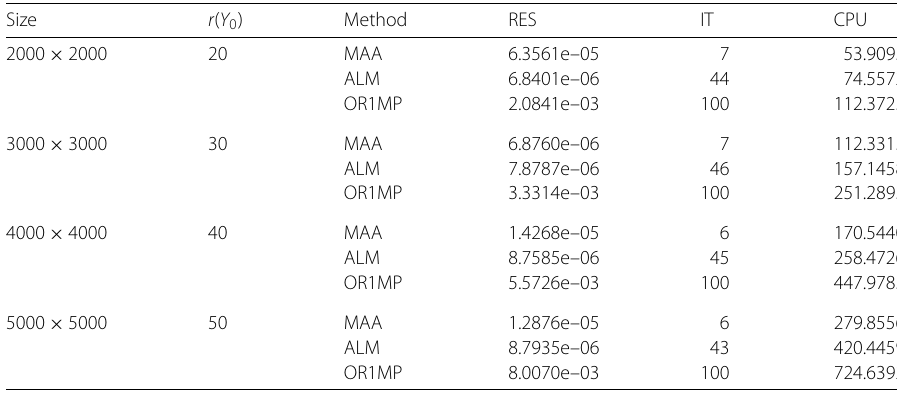
Table 3 Comparison results of three methods for p =